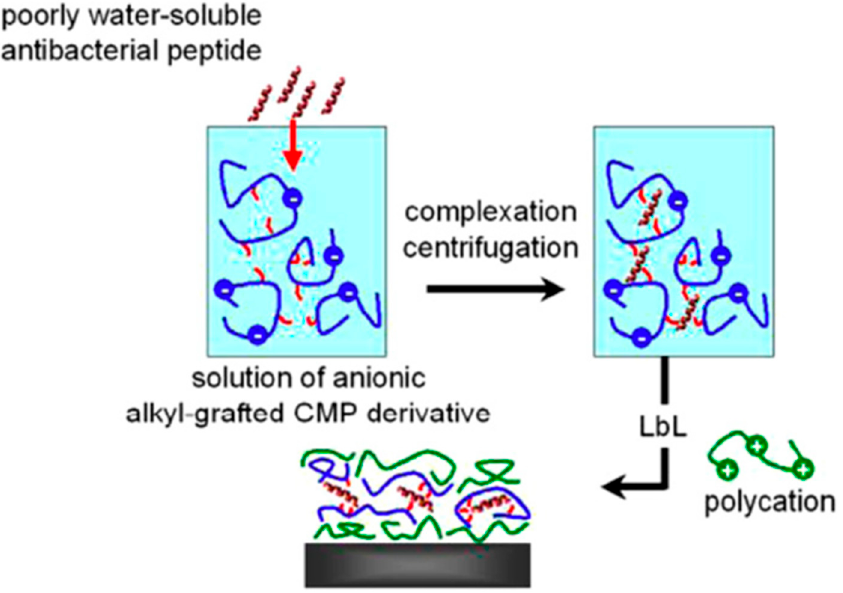
Figure 23. Process used for immobilization of Gramicidin A. Reproduced from [87]. Copyright © 2008 WILEY ‐ VCH Verlag GmbH & Co. KGaA, Weinheim.